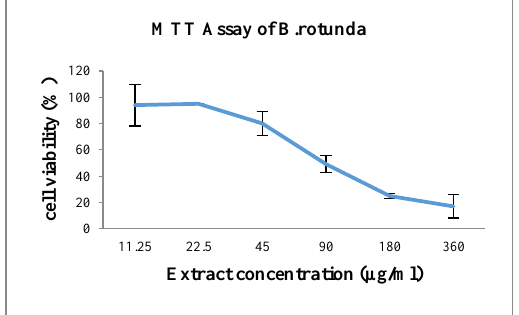
Figure 3: MCF-7 cancer cells viability after treated with B. rotunda ethanolic extracts.